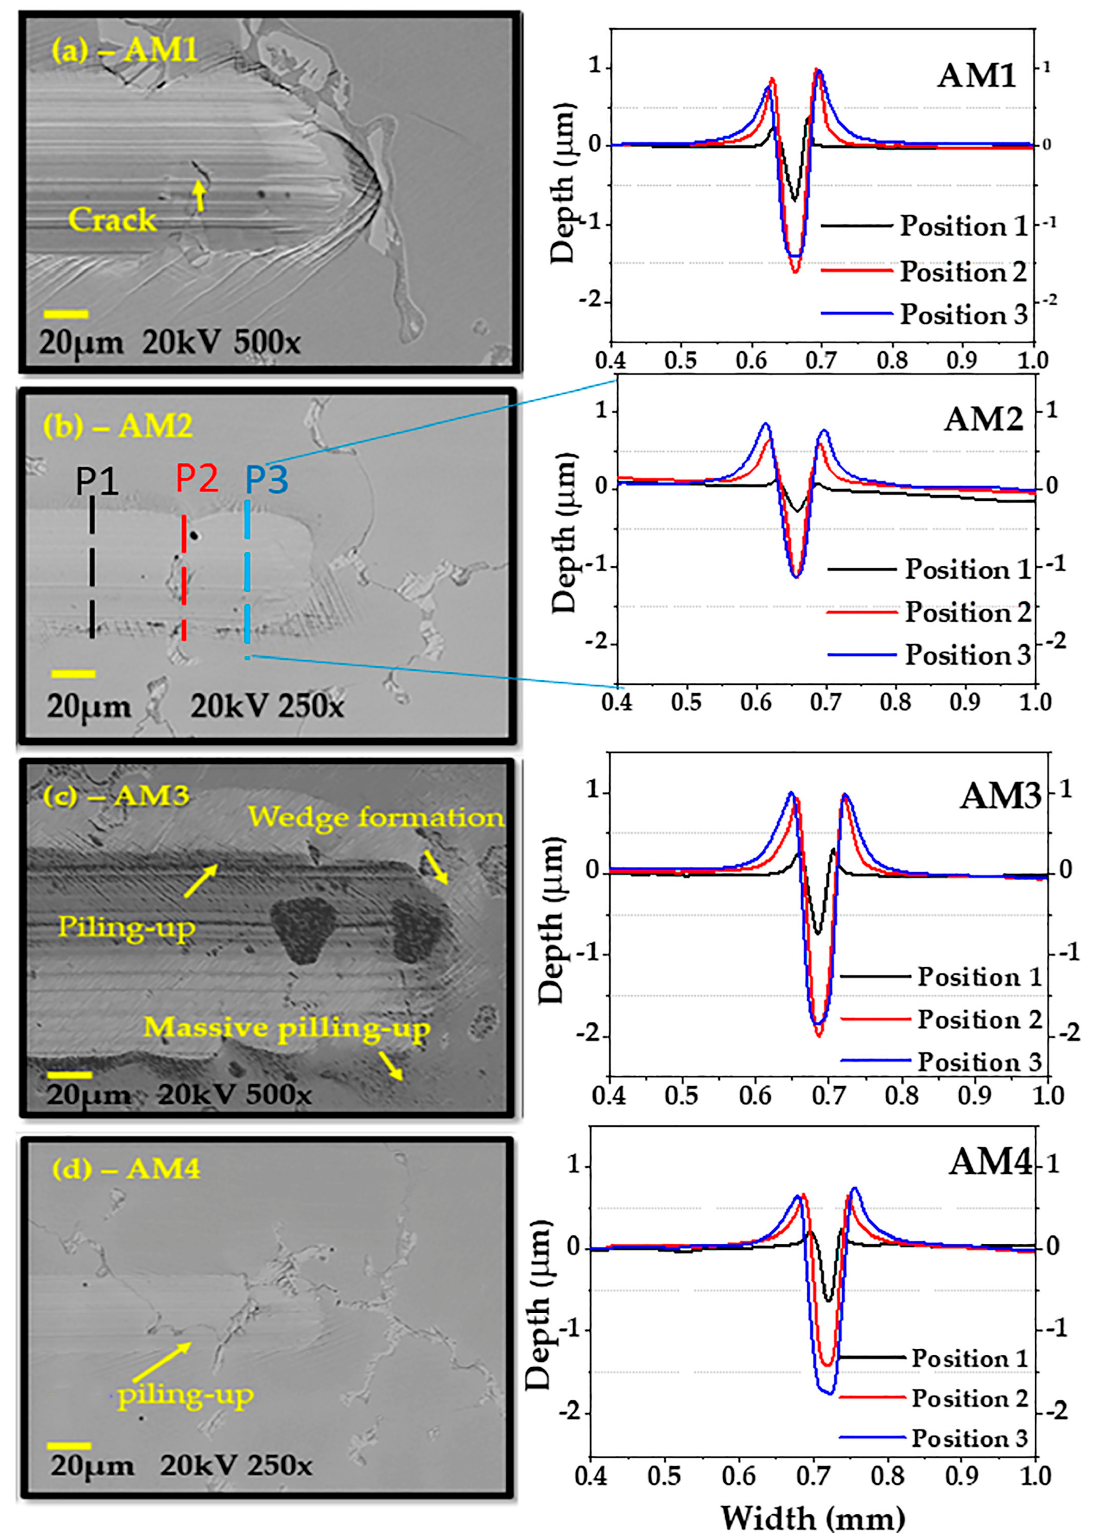
Figure 11. SEM images of the scratch grooves and profiles at different positions of the scratch tracks for samples ( a ) AM1, ( b ) AM2, ( c ) AM3, and ( d )